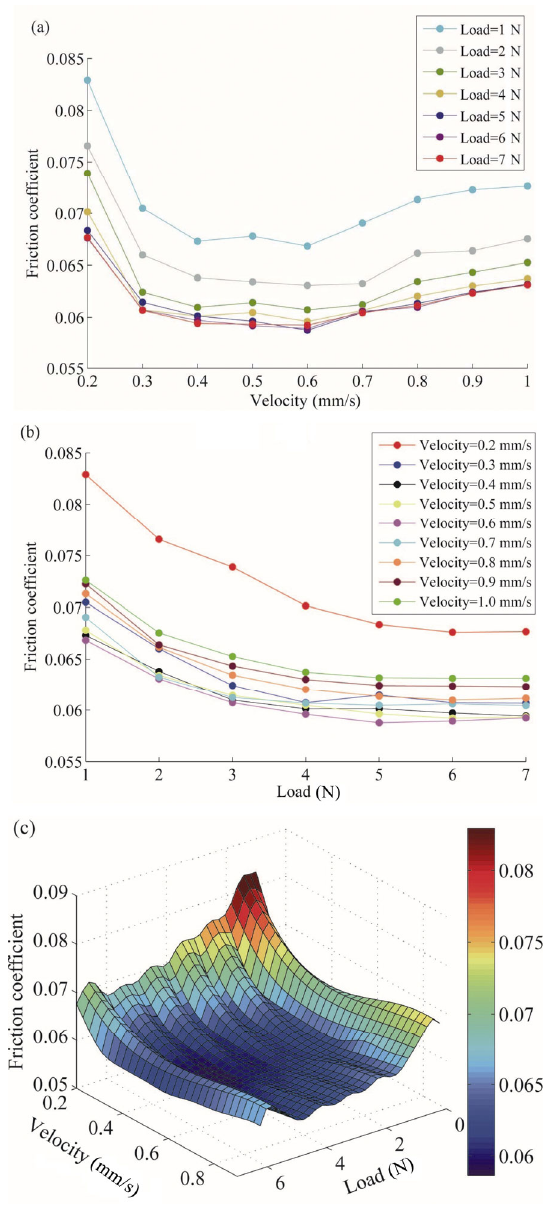
Fig. 4 Effects of (a) load, (b) velocity, and (c) co-influence of load and velocity on the friction